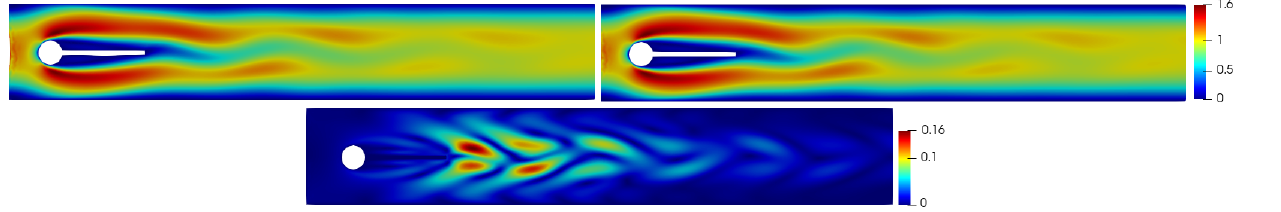
Figure 20. Fluid velocity: FE solution ( top left ), reduced order solution ( top right ), and local approximation error ( bottom ). = 13 basis The approximation was obtained with N u f